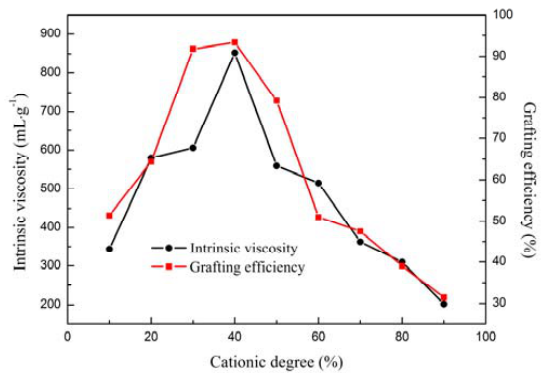
Figure 2. Effect of cationic degree on Intrinsic viscosity and Grafting efficiency of CPCTS ‐ g ‐ P (CTA ‐ DMDAAC).